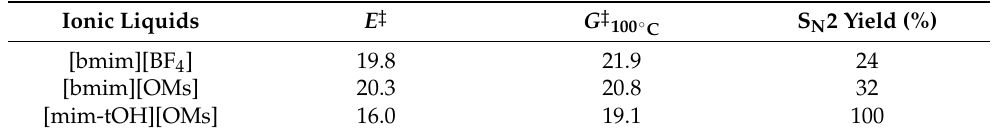
Table 7. Experimentally Observed Relative Efficiency and Calculated Barriers of S N 2 Reactions